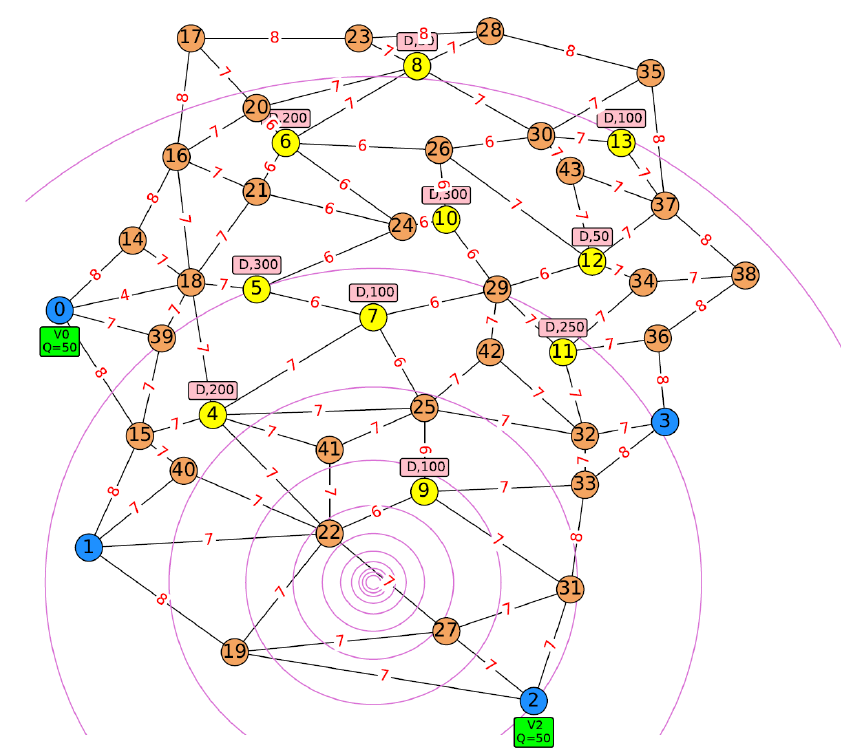
Figure A10. Road network for instance D4N30S10.